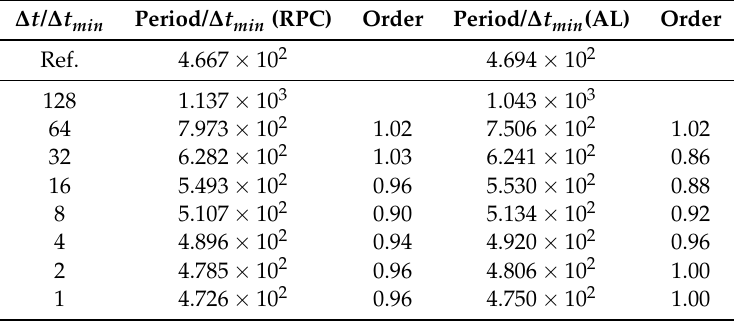
Table 8. Period of the oscillations with the rotational pressure-correction (RPC) and the augmented Lagrangian (AL) with a Gear 1 temporal scheme for the flow past a cylinder at Re = 100.